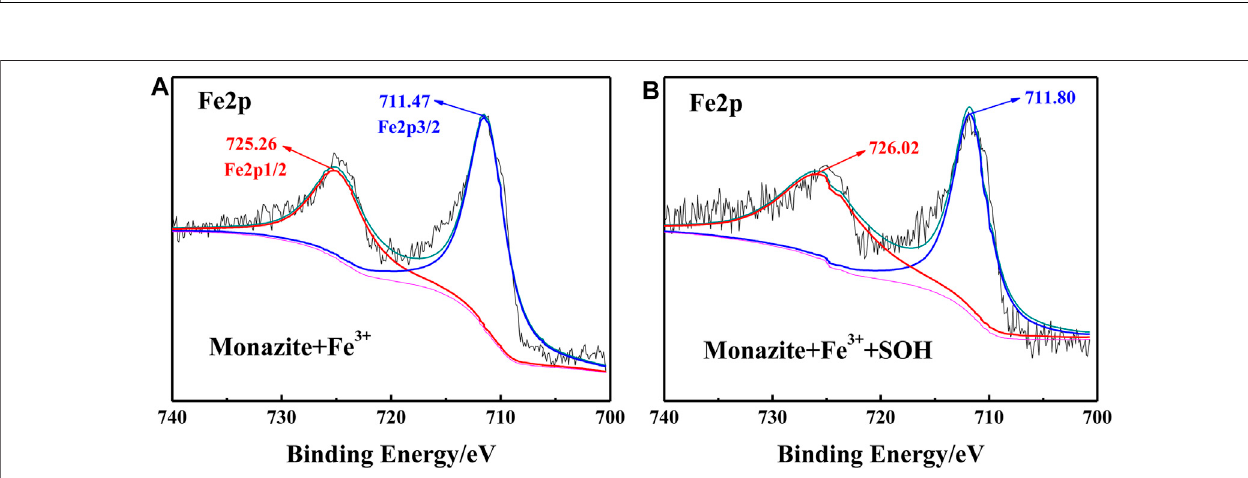
Frontiers in Chemistry |